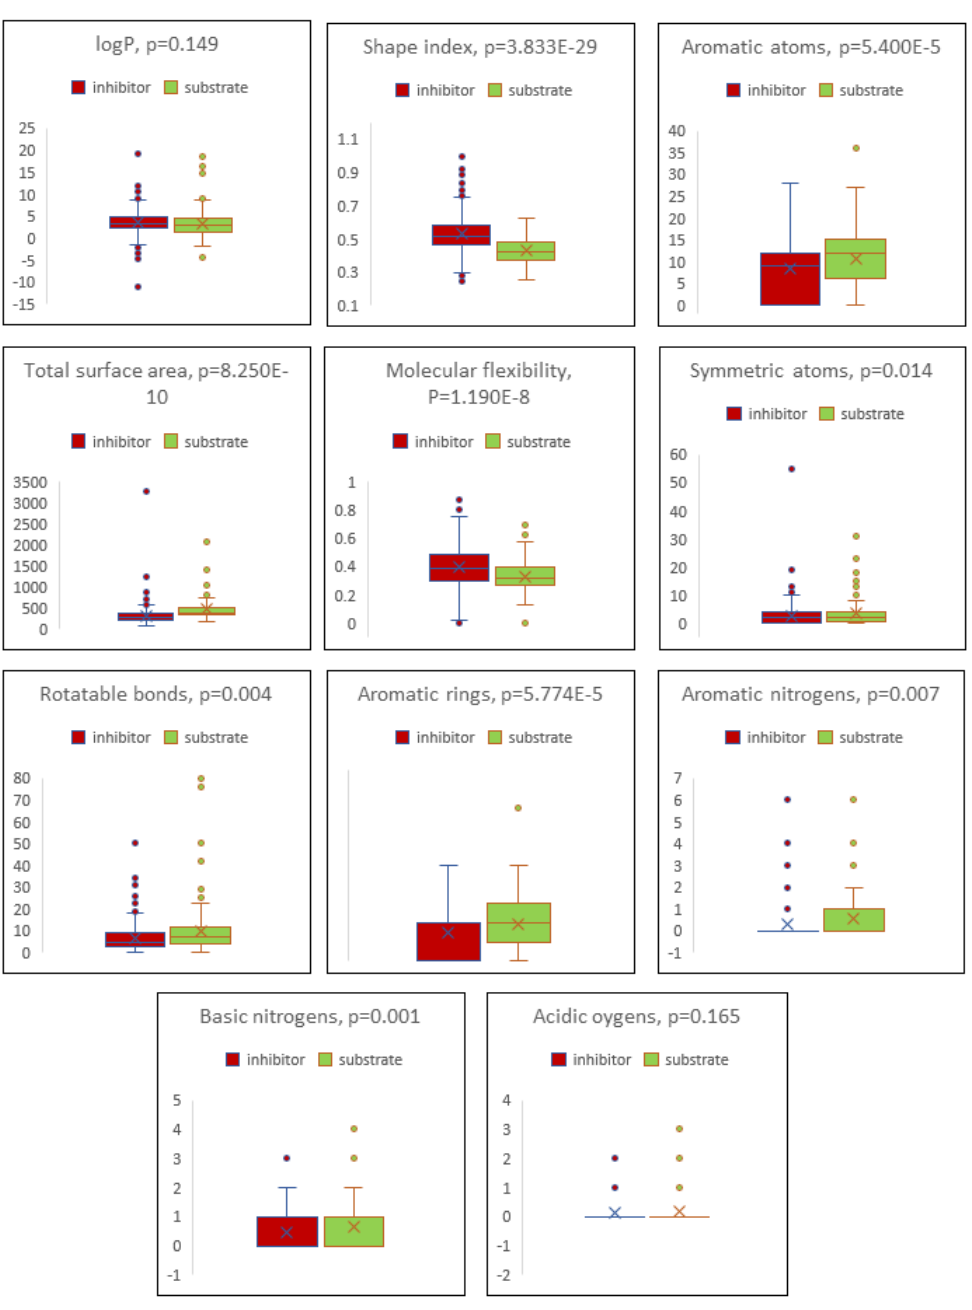
Figure 5. Boxplot analysis of the descriptors used for the model and comparison of the predicted inhibitors and substrates. Table 11. Average values of descriptors for inhibitors and substrates.